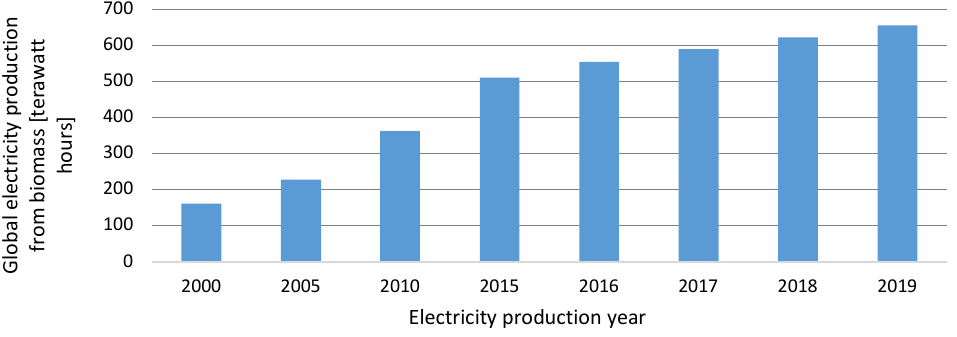
Figure 7. Global electricity production from biomass (2000–2019) [30].